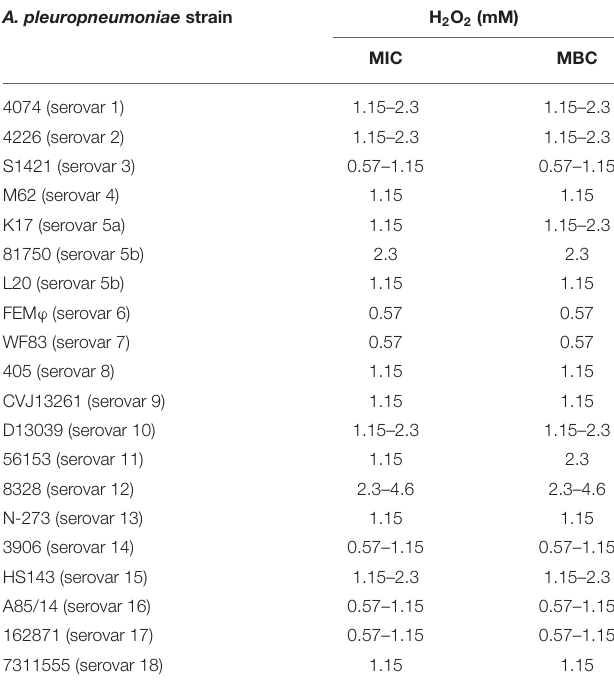
TABLE 1 | Minimum inhibitory concentration (MIC) and minimum bactericidal concentration (MBC) values of H 2 O 2 against A. pleuropneumoniae . A. pleuropneumoniae